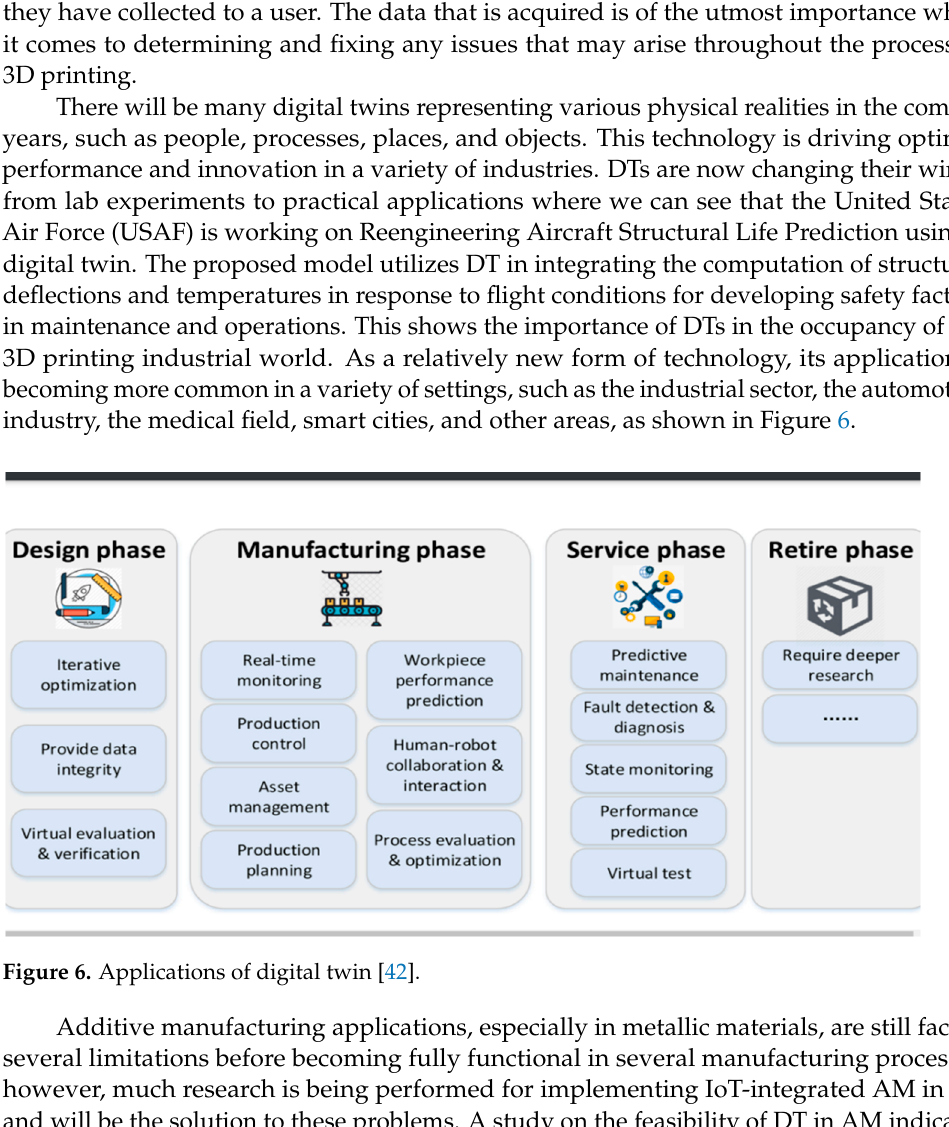
Figure 7. Digital twin applications in AM. Although there are other traditional systems, such as drafting and modeling software, analysis, and control strategies, there is higher scope for the automation and optimization of twinning physical models in order to encounter problems through DT (see Figure 7 above). A digital twin, which involves building a bridge between the physical and virtual worlds of printing, can cut down on the number of trial-and-error tests, reduce the risk of defects, shorten the amount of time that elapses between the design stage and the produc- tion stage, and make printing more metallic products more cost-e ff ective [43]. The Cyber- Physical Production System (CAPP) acts as a platform for integrating several virtual twins